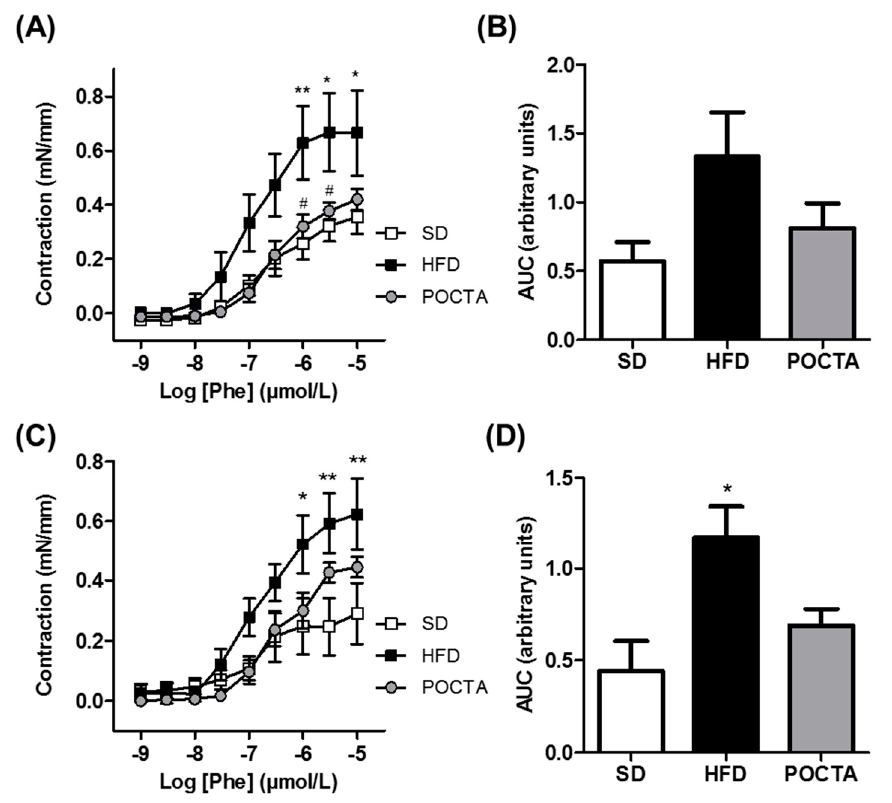
Figure 5. The effect of a POCTA diet on vasoconstriction in the aorta. Concentration-response curves to phenylephrine (Phe) in the absence of inhibitors ( A , B ), or in the presence of the inducible NO synthase inhibitor 1400W ( C , D ), in aortic rings of mice fed the SD, HFD, or POCTA diet. Area under the curves (AUC) obtained from cumulative curves to Phe in the absence ( B ), or presence of the inhibitor ( D ). Values are mean ± SEM ( n = 5) and are normalized relative to the control group. * p < 0.05, ** p < 0.01 vs. SD; # p < 0.05 vs. HFD.